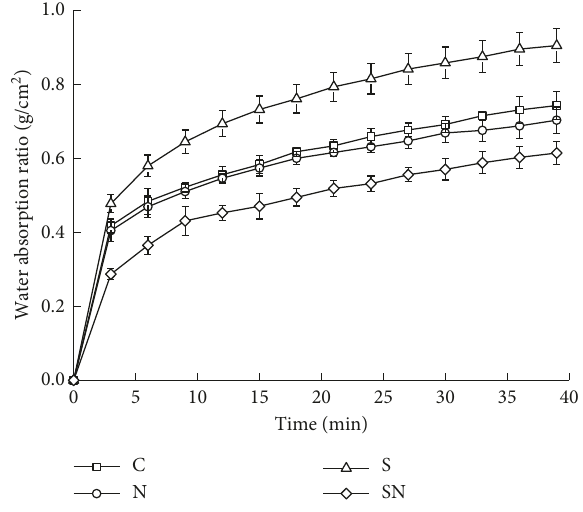
Figure 7: The water uptake after self-healing.